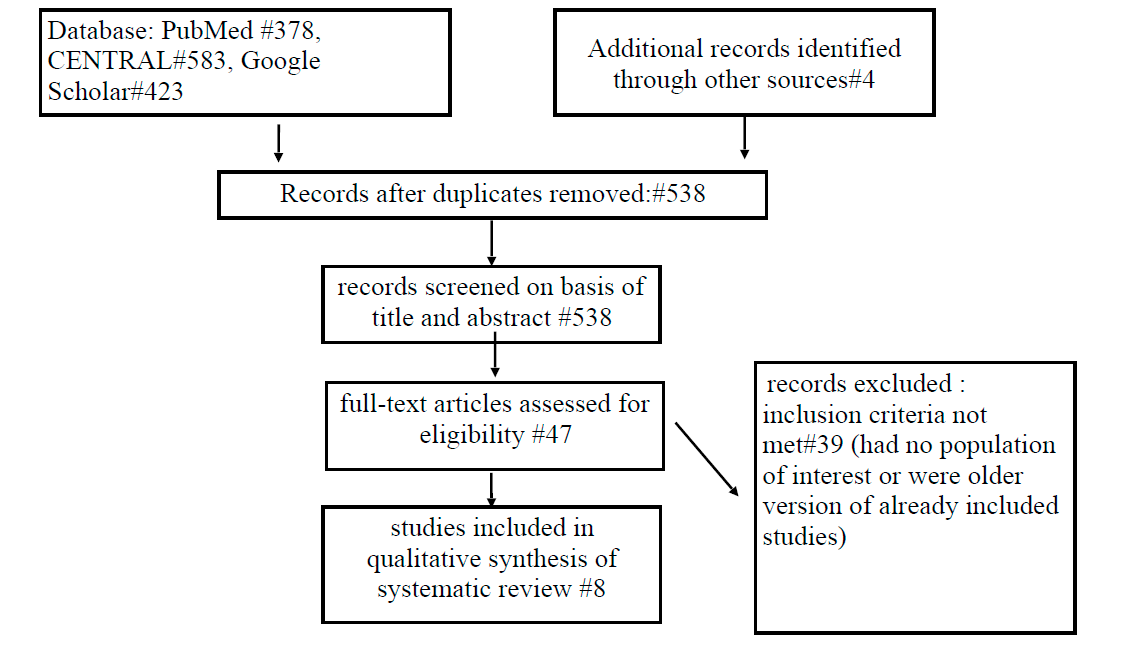
Figure 1. PRISMA flowchart. Table 1. Characteristics of included studies.